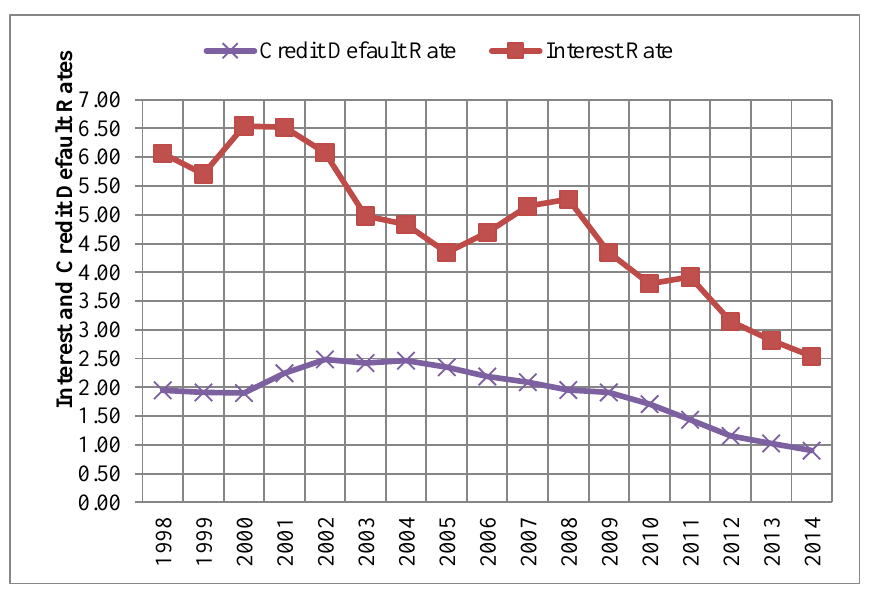
Fig. 3. The interest and credit default rates in Germany, 1998–2014 (developed by the author, based on data by Statista